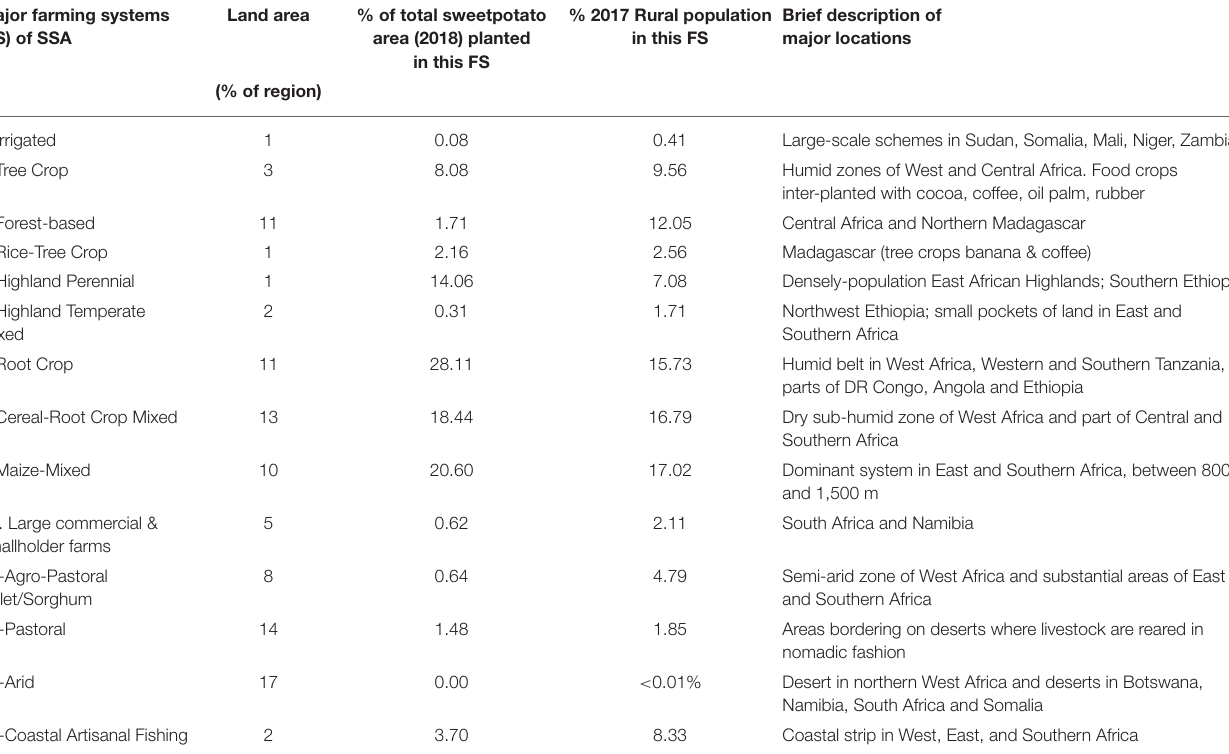
TABLE 2 | Major farming systems in SSA, the percent of land area occupied and where located, and the percent of population and sweetpotato area in each system. Major farming systems Land area % of total sweetpotato % 2017 Rural population Brief description of (FS) of SSA area (2018) planted in this FS major in this FS